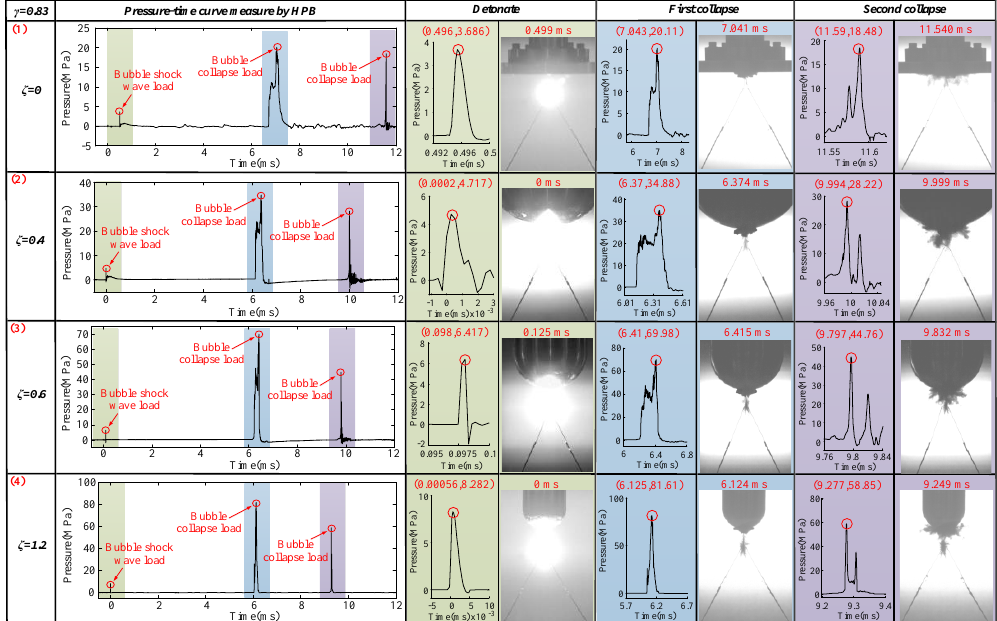
Figure 18. Pressure–time diagram for γ = 0.33 and different ζ values. The first row shows the pressure–time curves for the states of ζ = 0 and γ = 0.33. The second row shows the pressure–time curves for the states of ζ = 0.4 and γ = 0.33. The third row shows the pressure–time curves for the states of ζ = 0.6 and γ = 0.33. The fourth row shows the pressure–time curves for the states of ζ = 1.2 and γ = 0.33.